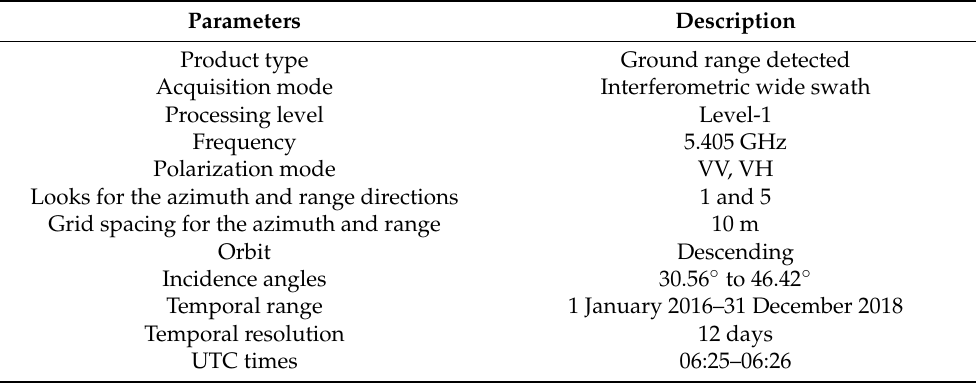
Table 1. Information of the Sentinel-1A